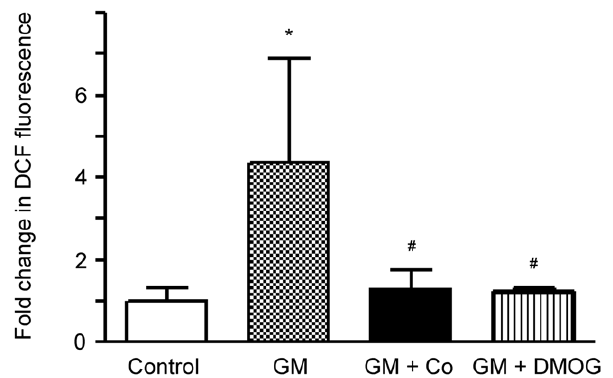
Figure 3. Effects of cobalt or DMOG pre-treatment on gentamicin-induced ROS generation in HK-2 cells. Gentamicin- induced increases in intracellular ROS were revealed by fluorescent intensities of 2 9 ,7 9 -dichlorofluorescein. The fluorescent intensities of the cells are shown as the relative intensities of the experimental groups compared with control cells. A representative set of three independent experiments is shown. The results are expressed as the mean 6 s.d. *Significantly different with respect to control cells. # Significantly different with respect to gentamicin-treated cells. * # P , 0.05. GM, gentamicin treatment; GM + Co, cobalt pre-treatment and gentamicin treatment; GM + DMOG, DMOG pre-treatment and gentamicin treat- ment.